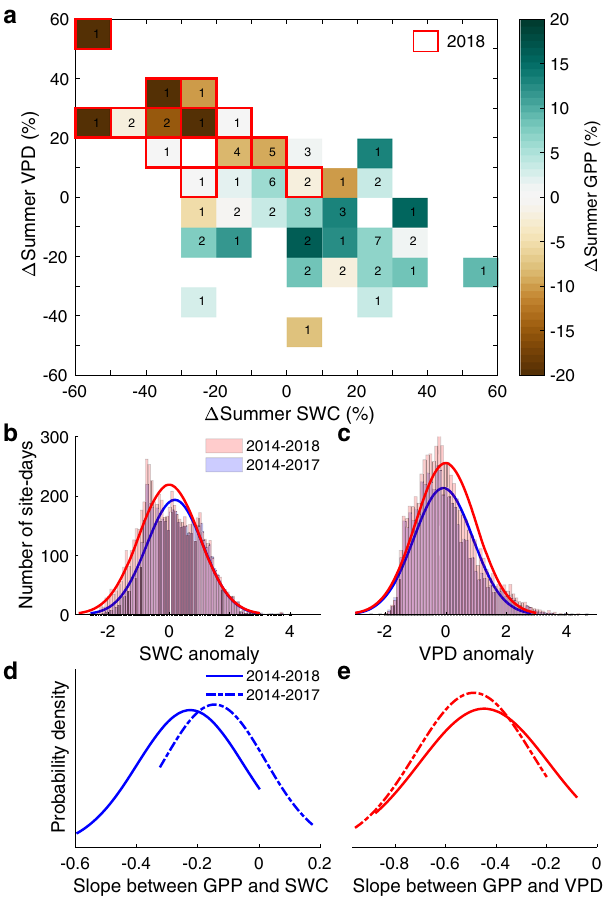
Fig. 1 Response of gross primary production to soil water content and vapor pressure de fi cit. a The response of the relative changes of summer gross primary production (GPP) to the relative changes of summer soil water content (SWC) and vapor pressure de fi cit (VPD) during 2014 – 2018. The observations from 2018 are distributed in the highlighted boxes with red borders while the 2014 – 2017 are mainly distributed in the other boxes (see also Supplementary Fig. 1). The number indicates the number of